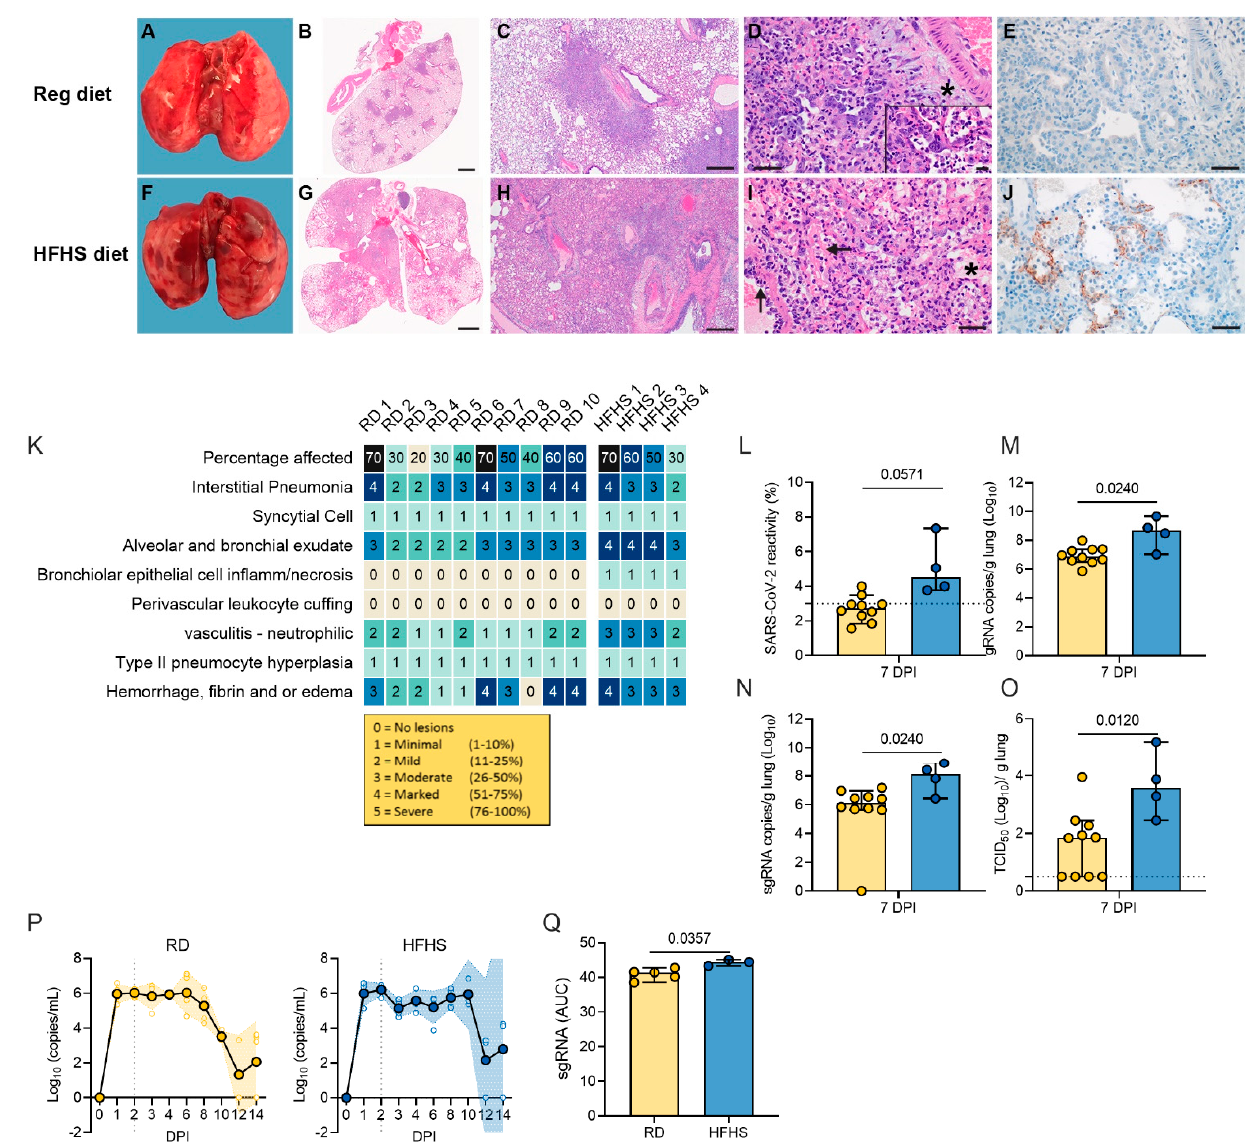
Figure 4. High-fat and high-sugar diet is associated to increased pulmonary pathology and decreased viral clearance. Animals were euthanized at 7 DPI with SARS-CoV-2 in order to compare lung pathology and viral titers. ( A – J ) Gross and photomicrographic images of hamster lungs taken at 7 DPI. ( A , F ) Gross necropsy findings consisted of multifocal well-circumscribed dark red foci throughout turgid lobes which failed to collapse. ( B , G ) Dark red foci in the gross images correlate with the consolidated foci adjacent to airways and scattered along the pleural margin in the sub-gross images. HE 1.4×. ( C , H ) Foci of interstitial pneumonia adjacent to terminal bronchioles and accompanying blood vessels. HE 20×. ( D , I ) Pneumonia consists of alveoli containing neutrophils, eosinophils, alveolar and septal macrophages, fibrin, edema and septa lined by hyperplastic type II pneumocytes, HE 400×. Syncytial cells are common (see inset, HE, 1000×). Pneumonic areas in the HFHS diet hamsters frequently had abundant intra-alveolar edema (*) and organizing fibrin (>) mixed with inflammatory cells. Note the vessel wall disrupted by sub-endothelial leukocytes and cellular debris ( ⇓ ). ( E , J ) Anti-SARS-CoV-2 immunoreactivity in the lungs from the regular diet hamsters is rare compared to the frequent pneumocyte immunoreactivity in the lungs of the HFHS diet hamsters, IHC, 400×. ( K ) Individual pathological scores. ( L ) Quantitative count of SARS-CoV-2 immunoreactivity by morphometric analysis. Bar chart depicting median, 95% CI, and individuals, n = 10 (RD)/4 (HFHS), Mann–Whitney test. ( M , N ) Lung viral load measured by g and sgRNA. Bar chart depicting median, 95% CI and individuals, n = 10 (RD)/4 (HFHS), Mann–Whitney test. ( O ) Infectious virus measured by lung titration. Bar chart depicting median, 95% CI and individuals, n = 10 (RD)/4 (HFHS), Mann–Whitney test. ( P ) Viral load in oropharyn- geal swabs measured in sgRNA copy number for RD and HFHS animals. Graphs show median, individual animals and 95% CI (shaded area). Dotted line = peak shedding. ( Q ) Area under the curve (AUC) analysis of virus shedding shown in